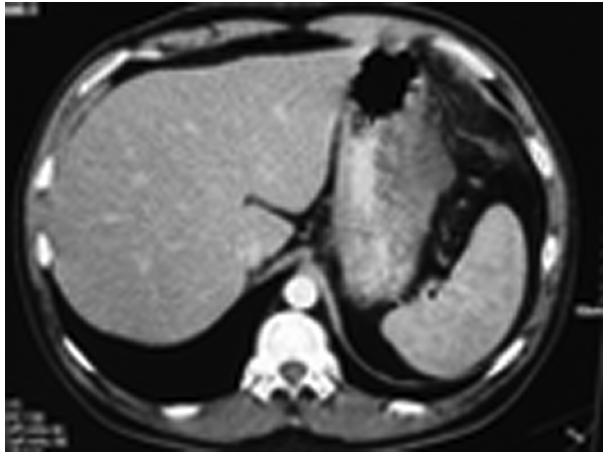
Figure 1 - Computed tomography showing the gastric wall